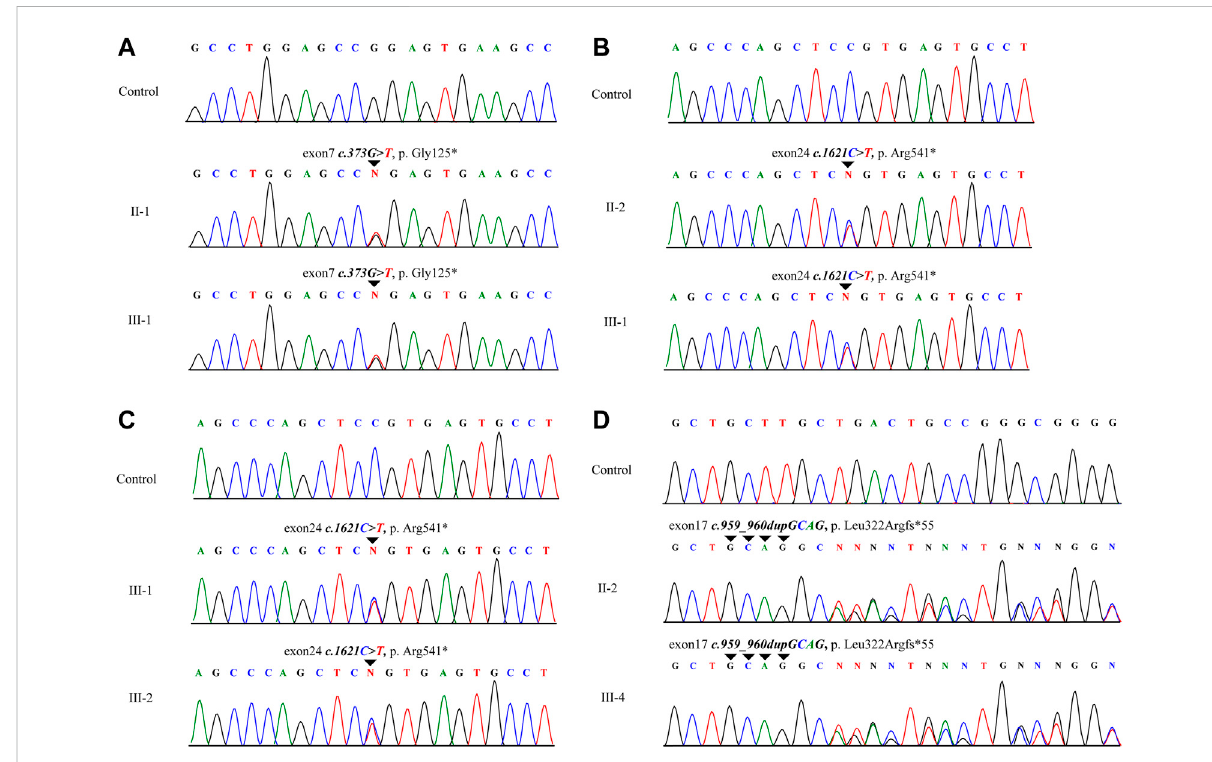
FIGURE 2 SchematicofasubsetoftheELNmutationsidenti fi edinthisstudy.Theschematicpositionsofidenti fi edmutationsarerepresentedbytriangles. (A – D) represent families A, B, D and I. II and III correspond to second and third generation,